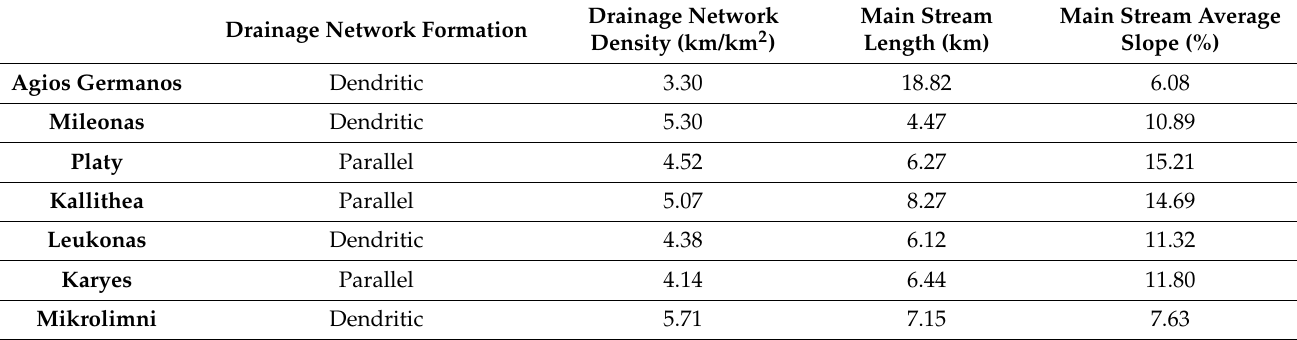
Table 2. Hydrographic characteristics of the watersheds in the study